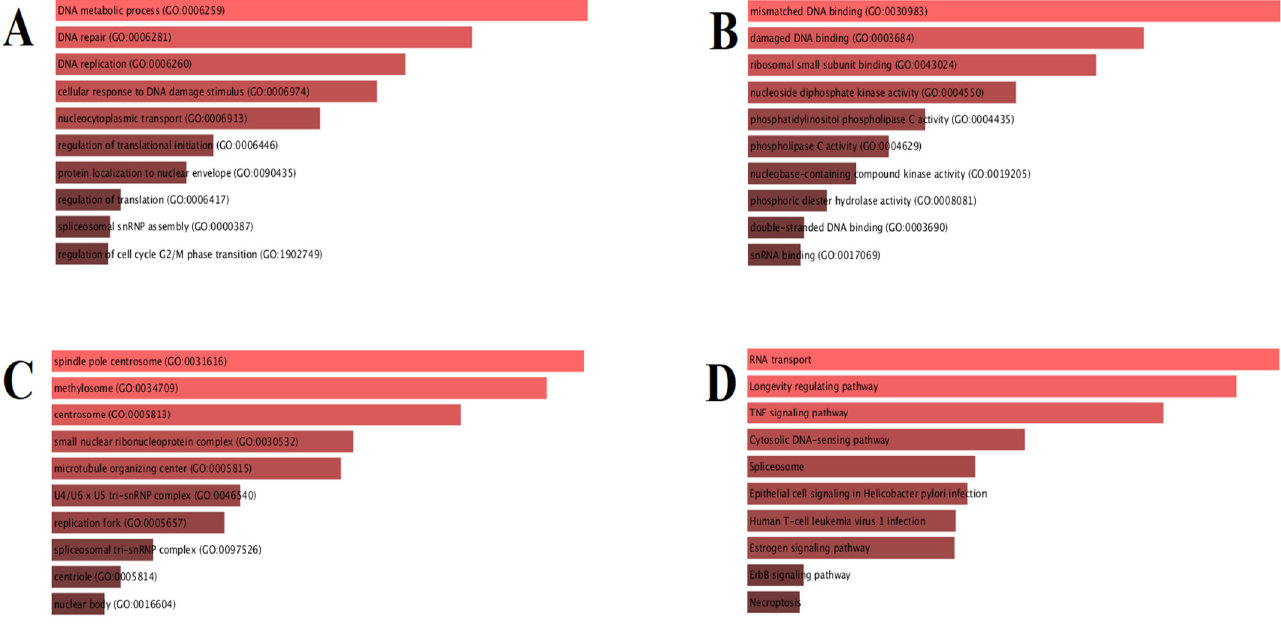
Figure 11. Gene ontology (GO) functional and Kyoto Encyclopedia of Genes and Genomes (KEGG) pathway enrichment analysis for the selected genes (performed via enricher) ( A ) GO Biological Process 2018; ( B ) GO Molecular Function 2018; ( C ) GO Cellular Component 2018; ( D ) KEGG 2019.